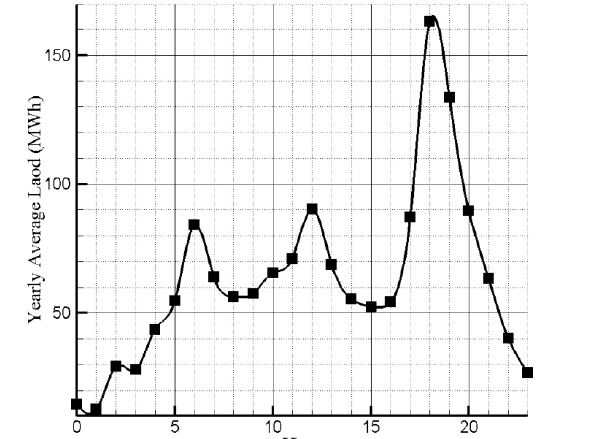
Figure 12. Yearly average electrical load of Sirjan